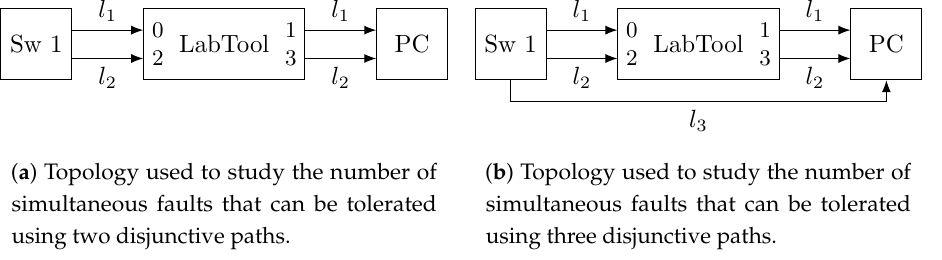
Figure 4. Topologies used to study the number of simultaneous permanent and temporary faults that can be tolerated using spatial redundancy